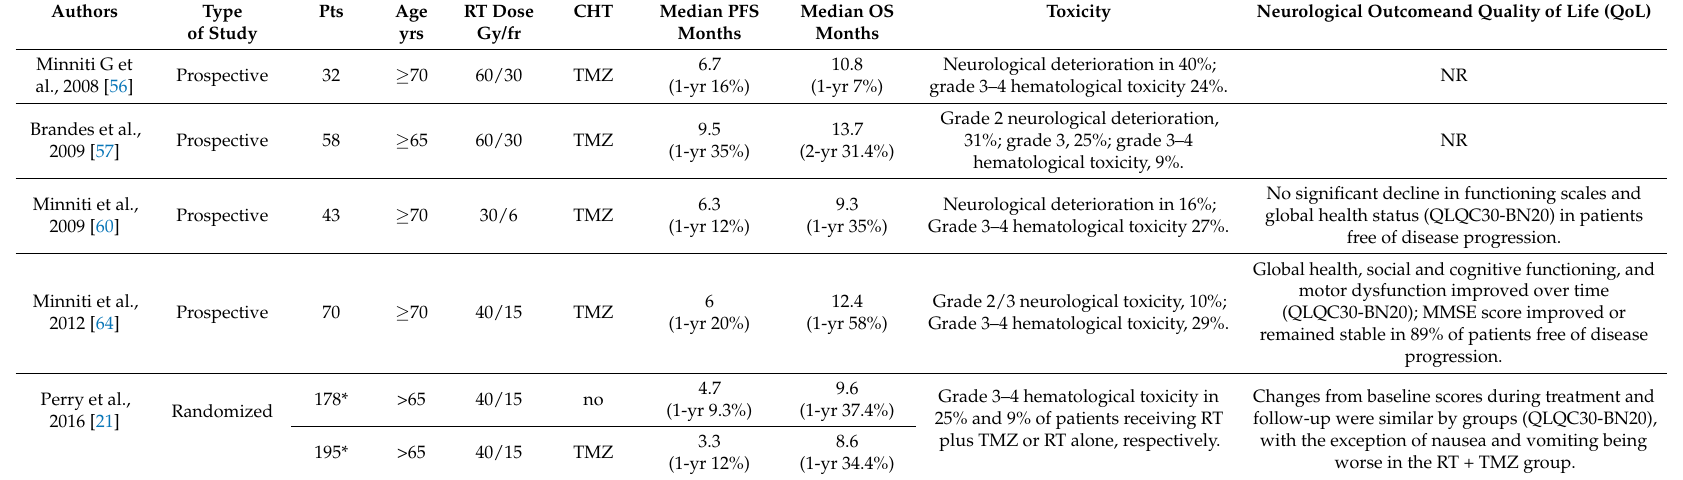
Table 2. Selected studies on combined radiochemotherapy in older patients with